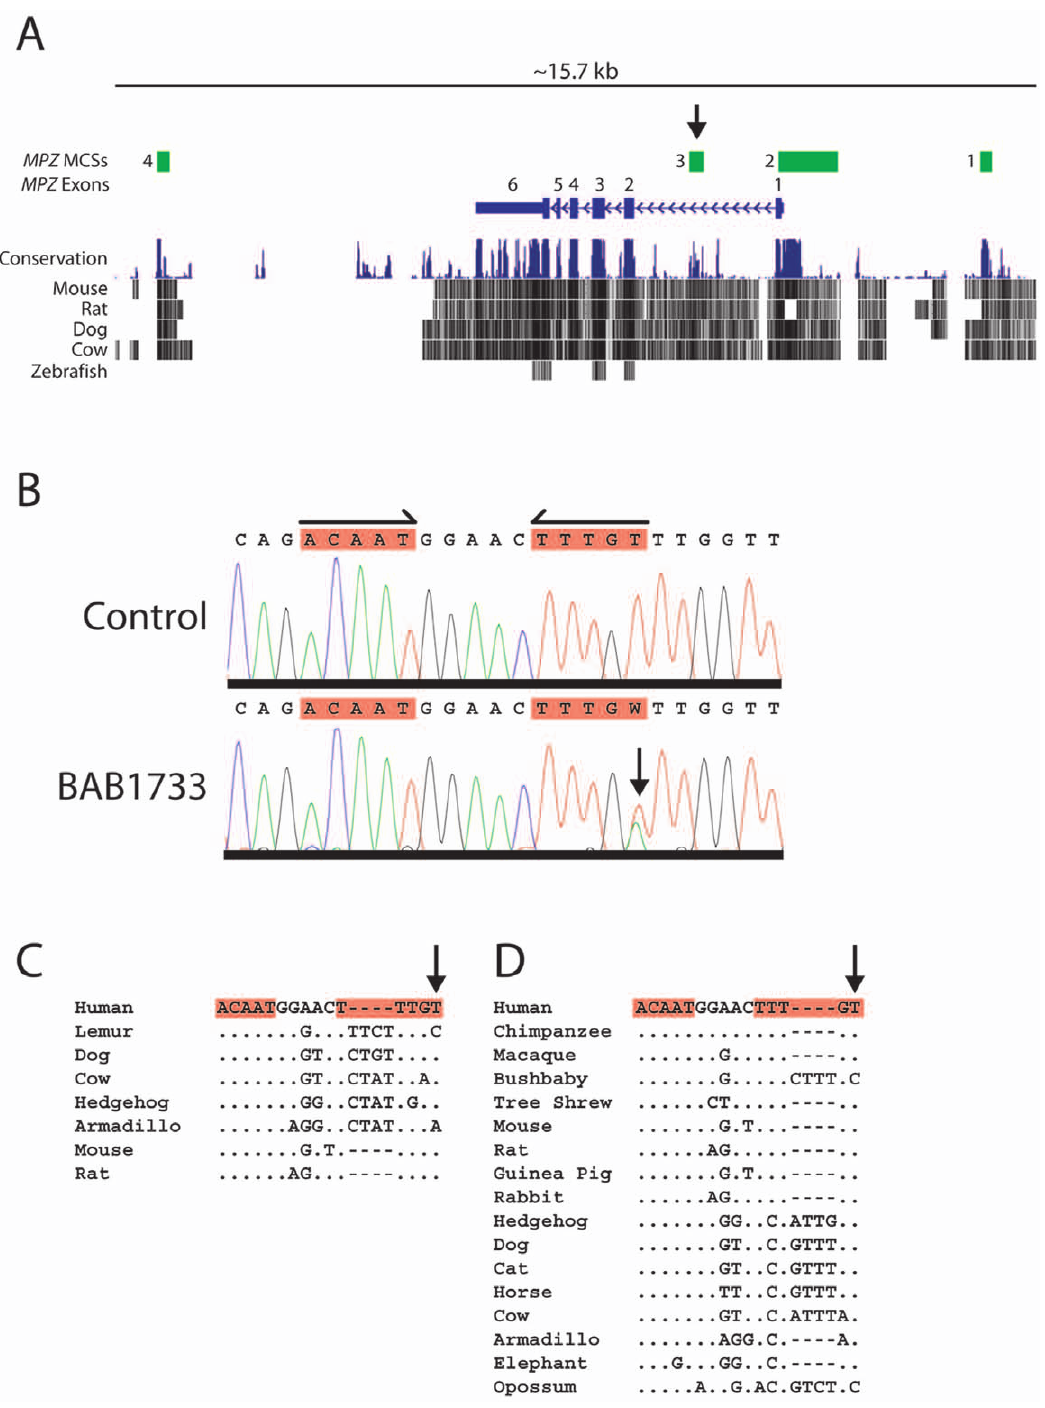
Figure 1. Analysis of MCSs in the genomic region encompassing MPZ . ( A ) Representation of the MPZ gene and its flanking regions from the UCSC Human Genome Browser. From top to bottom, tracks are shown displaying information about MPZ -MCSs, MPZ exons, overall multi-species sequence conservation, and pair-wise sequence conservation between human and five other vertebrate species. MPZ -MCS3 within MPZ intron 1 is indicated by an arrow. ( B ) Sequence chromatograms for a region within MPZ -MCS3 are shown for an unaffected individual (control) and patient BAB1733. Two monomeric consensus SOX10-binding sequences in a head-to-head configuration are indicated by red highlights and horizontal arrows. The position of the c.126-1086T . A variant (heterozygous in the patient) is indicated with a vertical arrow. ( C, D ) Multi-sequence alignments of the consensus SOX10-binding sequences within MPZ -MCS3 (highlighted in red) are shown containing sequences from the indicated species, as generated by MultiPipMaker ( C ) or available on the UCSC Human Genome Browser ( D ). The position of c.126-1086T in each alignment is indicated by a vertical arrow; dots indicate bases that are identical to the human reference sequence and dashes represent gaps within the alignments.